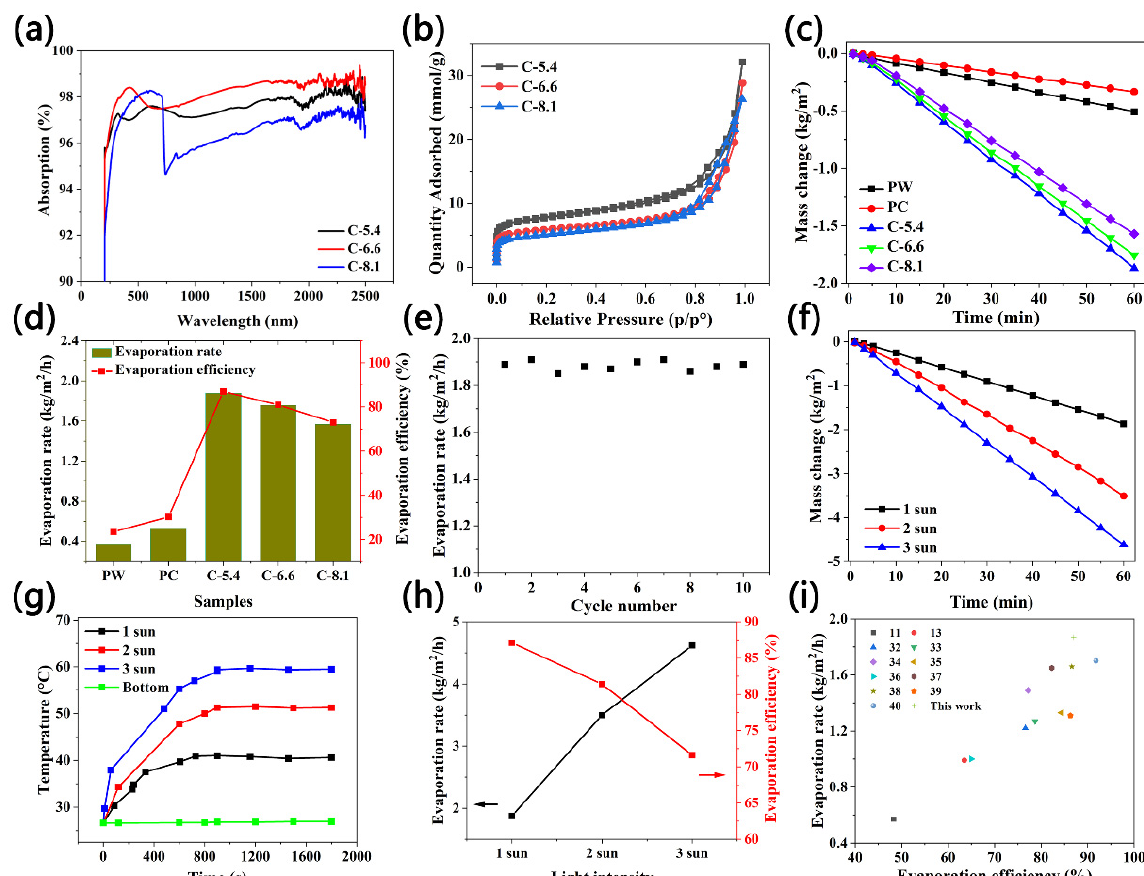
Figure 2. ( a ) Absorption spectra of C-5.4, C-6.6, and C-8.1 carbon nanomaterials. ( b ) Nitrogen adsorption/desorption isotherms. ( c ) The mass change in PW, PC, C-5.4, C-6.6, and C-8.1 samples under 1 sun. ( d ) The evaporation rate and efficiency of the PW, PC, C-5.4, C-6.6, and C-8.1 samples under 1 sun. ( e ) The cycling stability of the C-5.4 evaporator under 1 sun irradiation for 10-cycle evaporation measurements. ( f ) The mass change in the C-5.4 sample under 1, 2, and 3 sun. ( g ) The surface temperature change in the C-5.4 sample under 1, 2, and 3 sun, and the bottom temperature under 1 sun. ( h ) The evaporation rate and efficiency of the C-5.4 sample under 1, 2, and 3 sun. ( i ) The comparison of the evaporation rate and efficiency of the C-5.4 sample with those